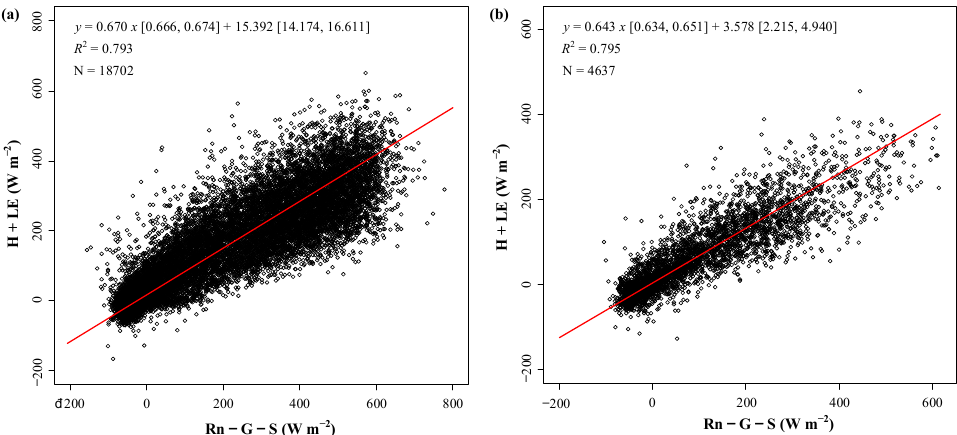
Figure 9. Relationship between the available energy in the system (Rn − G − S) and the sum of the sensible and latent heat fluxes (H + LE) during the ( a ) growing season and ( b ) dormant season. Rn is the net radiation; G is the soil heat flux; and S is the canopy heat storage. Solid red lines show the linear fit, and points represent 30-min averages. N is the number of samples included in each regression.